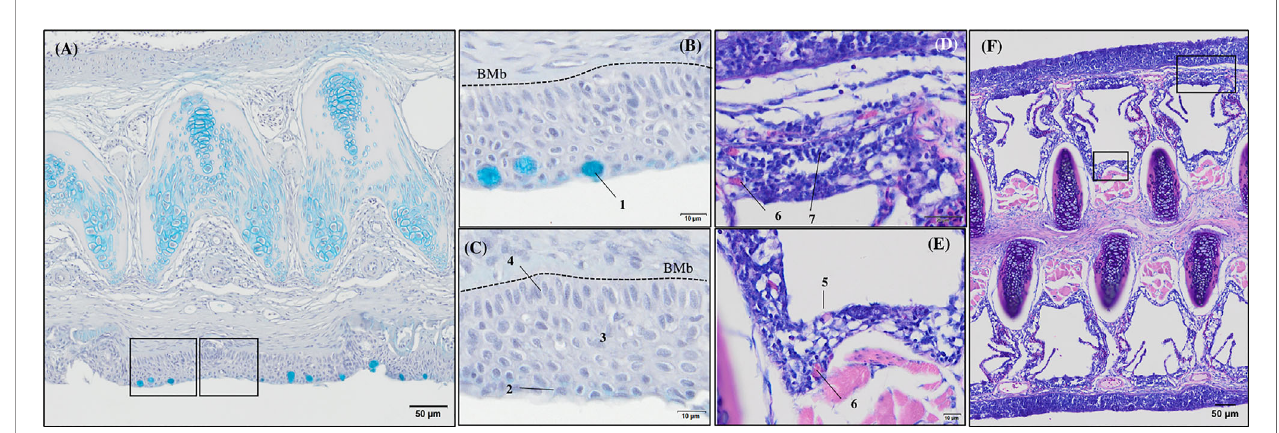
FIGURE 4 | General morphology of European sea bass ( Dicentrarchus labrax ) gill base section and gill associated lymphoid tissue leucocytes populations ’ distribution. (A-C) Representative micrograph of a transversal section of the gill base the second/third right holobranch (Alcian-Blue PAS, pH = 2.5; Bar = 50 & 10 μm). Observe the variations on the epithelial cells ’ nuclei orientation. (D-F) Representative transversal micrograph of the interbranchial lymphoid tissue (ILT) located at the gill base the second/third right holobranch (MGG; Bar = 50 & 10 μm). (1) Goblet cell, (2) surface epithelial cells, (3) mid epithelial cells, (4) basal epithelial cells, (5) rodlet cells, (6) granulocytes, (7) lymphocytes. BMb, basement